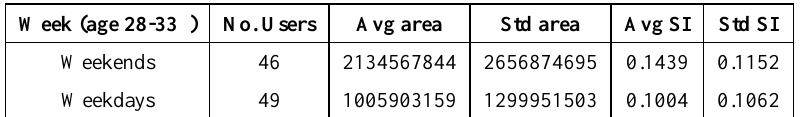
Table 7. Average and standard deviation of area and shape index of users between 28-33 based on days of the week.